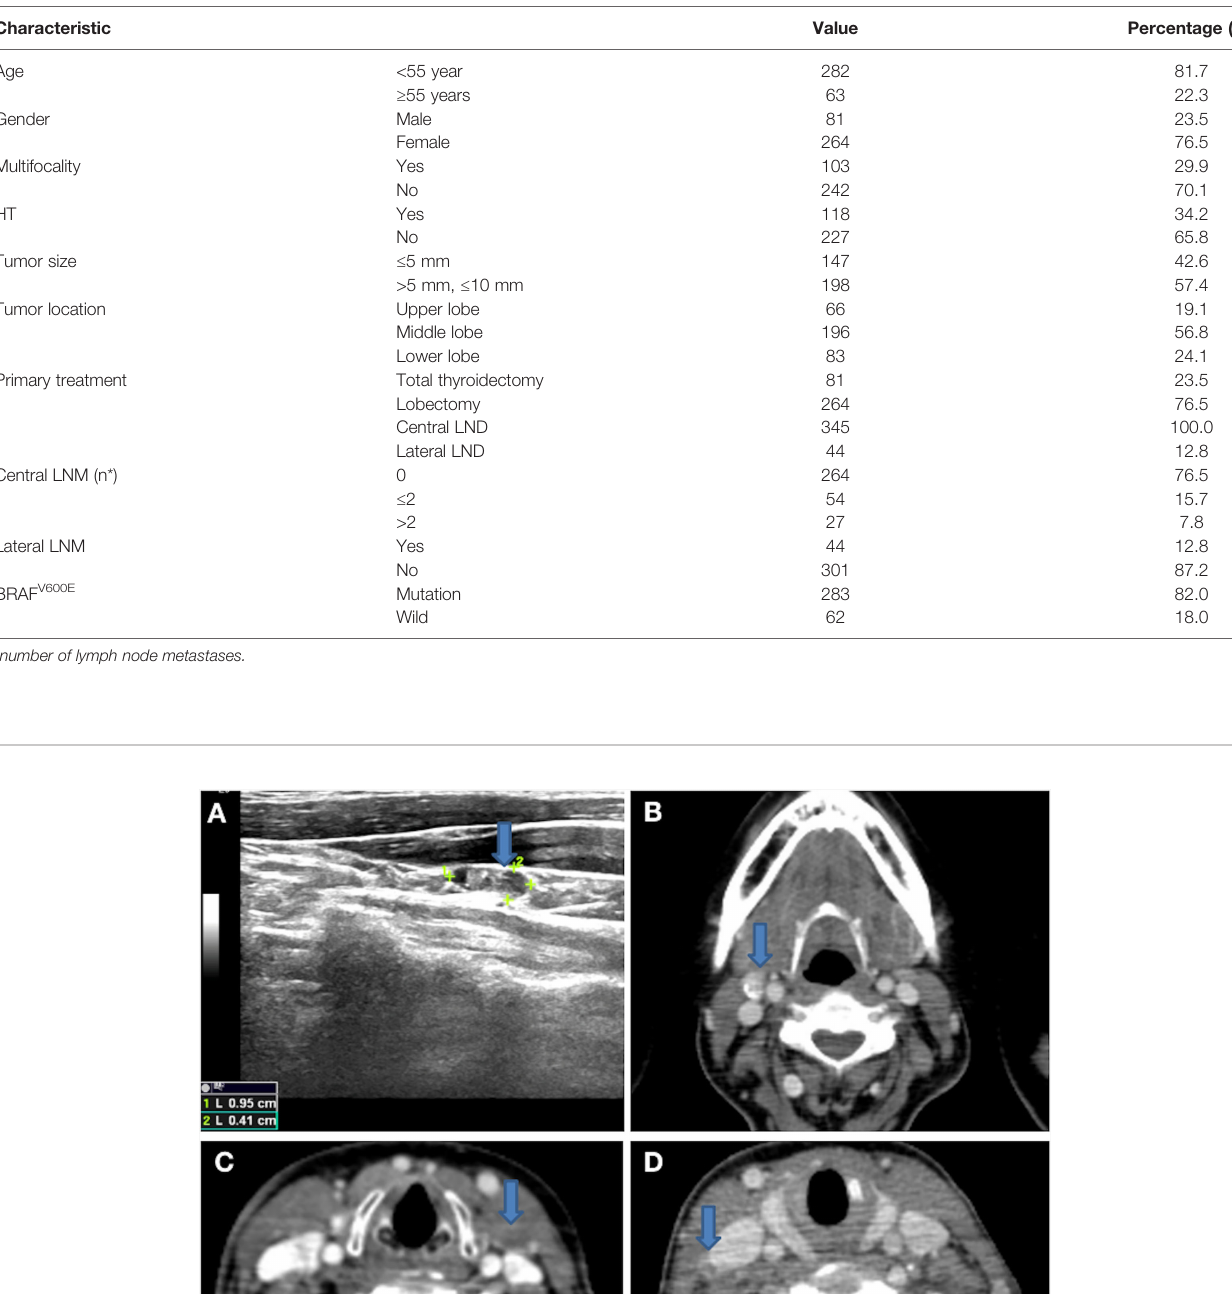
TABLE 1 | Demographics and clinicopathologic characteristics of